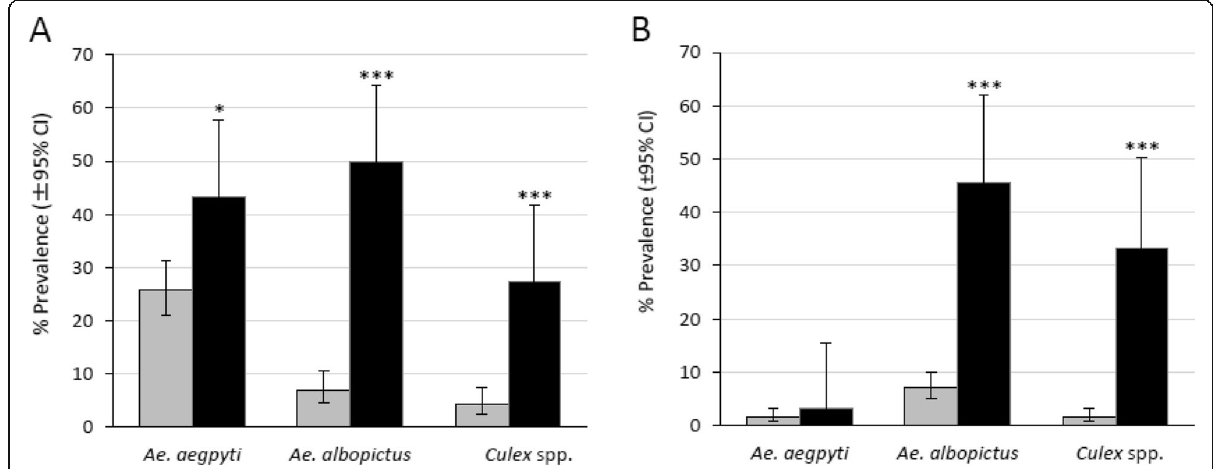
Fig. 4 Differences in the preference for water types among mosquito larvae species in two villages. a Prevalence rate in the control village for water in daily use (number of infestation by Ae. aegypti , Ae. albopictus , and Culex spp., respectively 70, 19, 12; n = 272) and stagnant water (19, 22, 12; n = 44) that was obtained in the pre-intervention period (October 2017) and intervention periods (February, July, and September 2018) were used to analyze. b Prevalence rate in the treated village for water in daily use (6, 28, 6; n = 396) and stagnant water (1, 15, 11; n = 33) obtained during intervention periods (February, July, and September 2018) was used to analyze. The comparison showed that Ae. albopictus strongly preferred stagnant water, while Ae. aegypti did not prefer stagnant water as strongly as Ae. albopictus. P values were calculated using Fisher ’ s